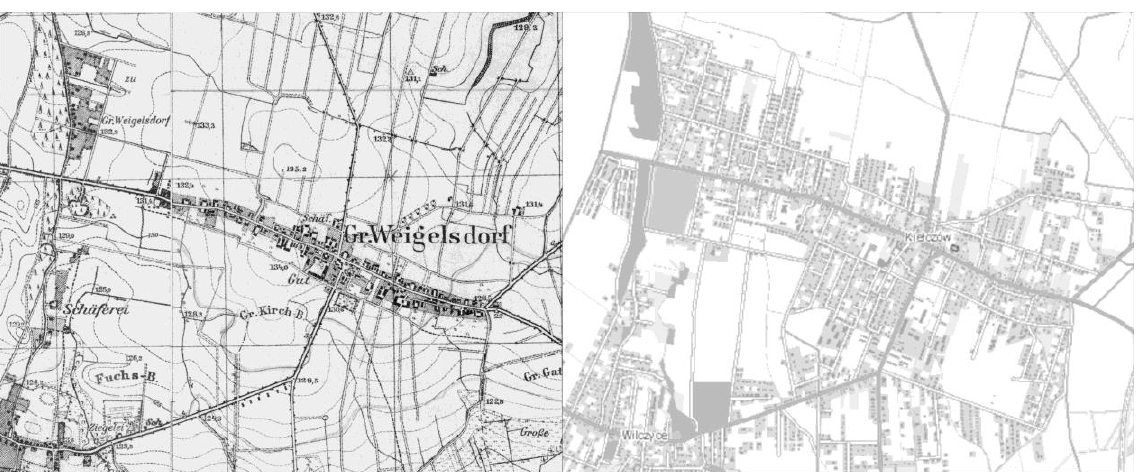
Fig. 8. Morphological transformation in Krzeptów Kąty Wrocławskie commune)